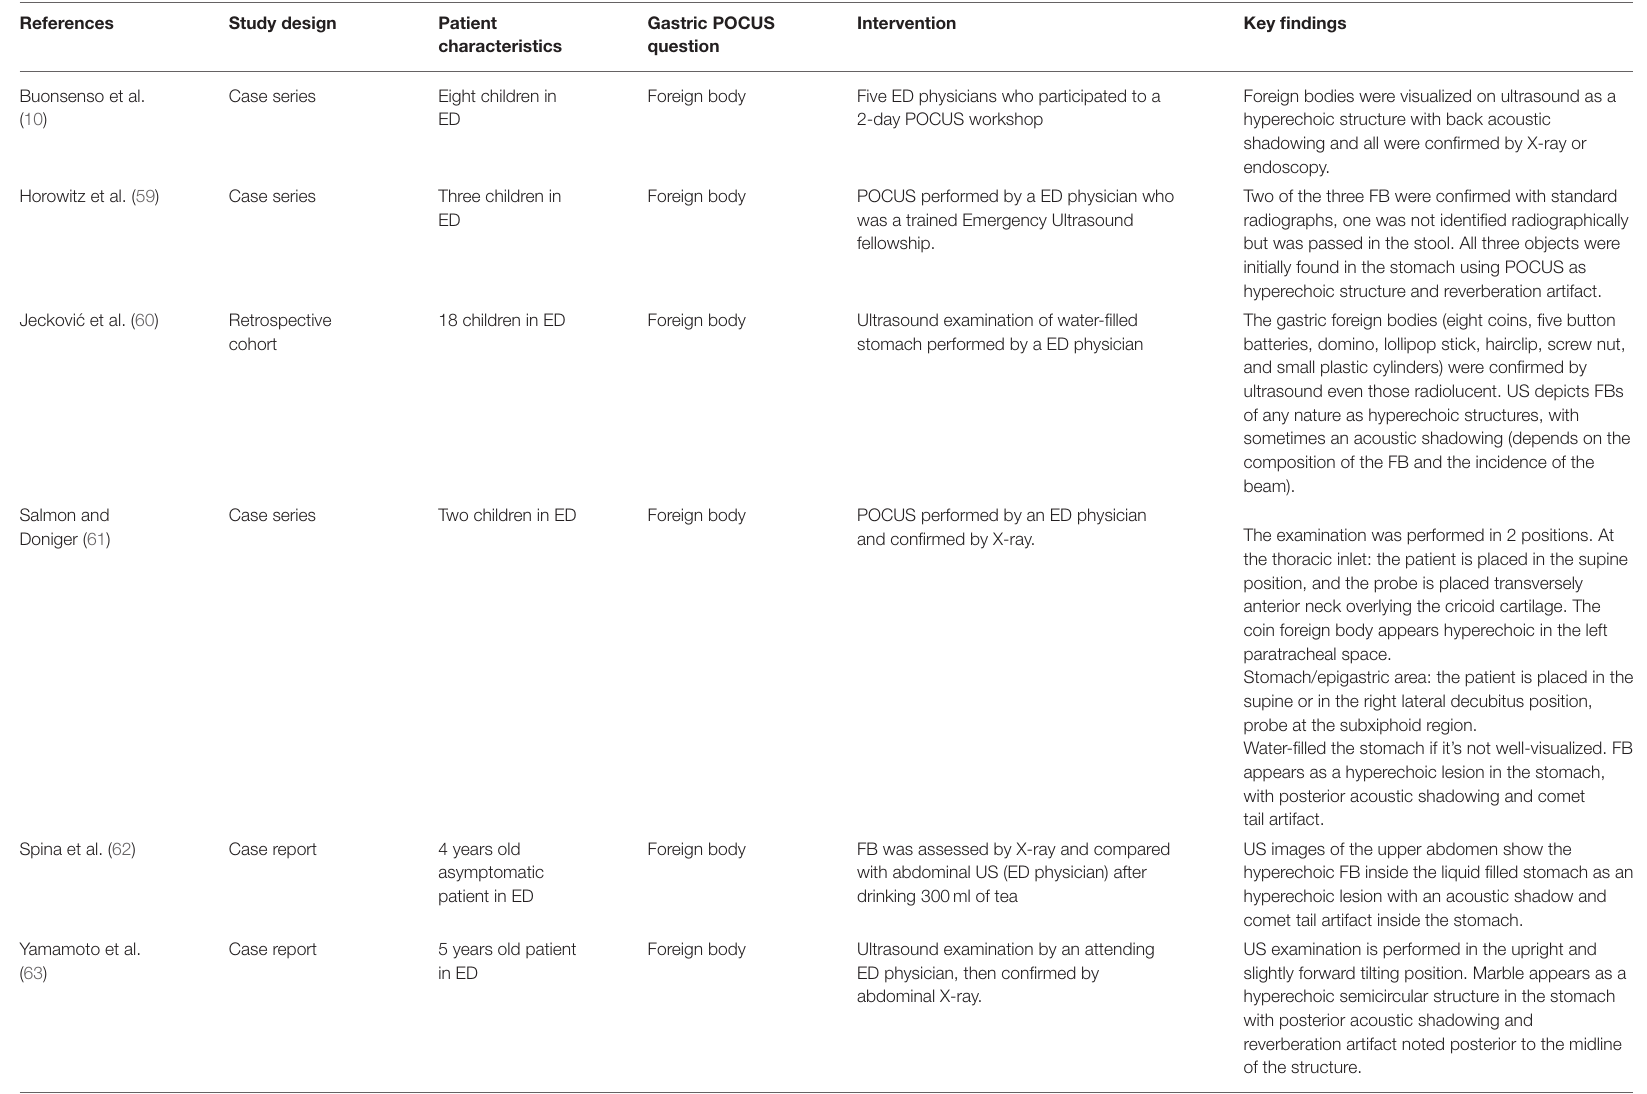
TABLE 2 | Study characteristics and findings: foreign body